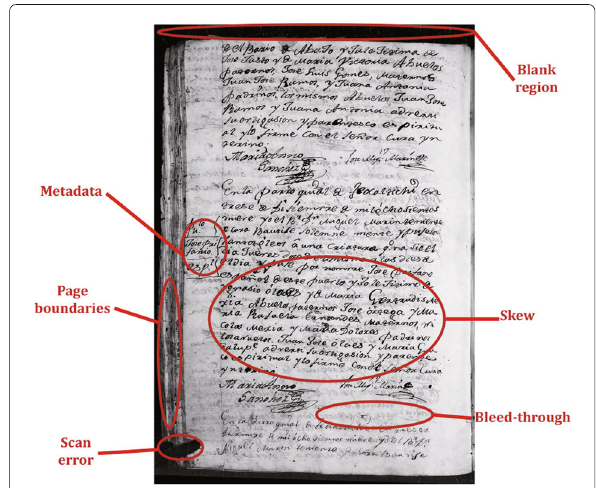
Fig. 1 Challenges in handwritten historical documents